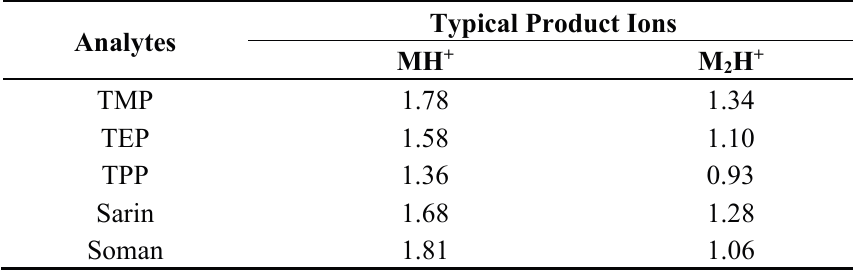
Table 1. The K 0 values for each CWA obtained though SPME-IMS in water analysis.